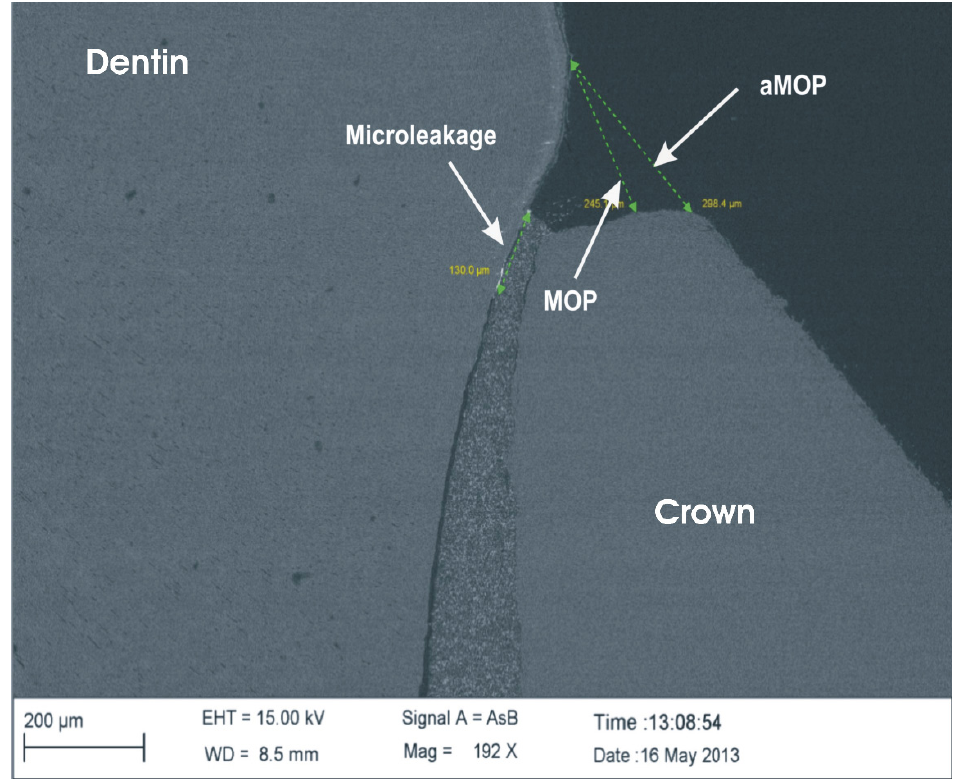
Figure 2. Measurements of microleakage, marginal gap (MOP) and absolute marginal gap